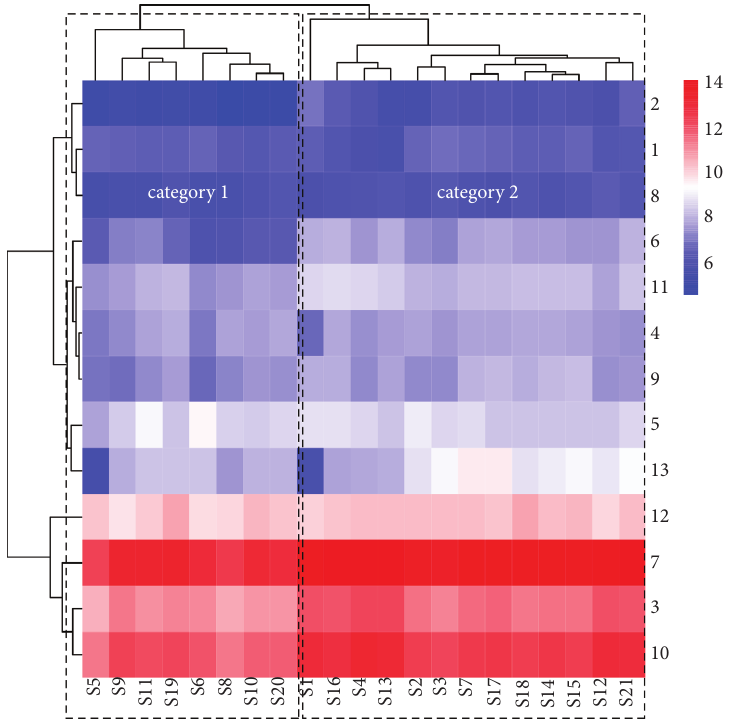
Figure 3: Heat map of the HCA of 21 batches of